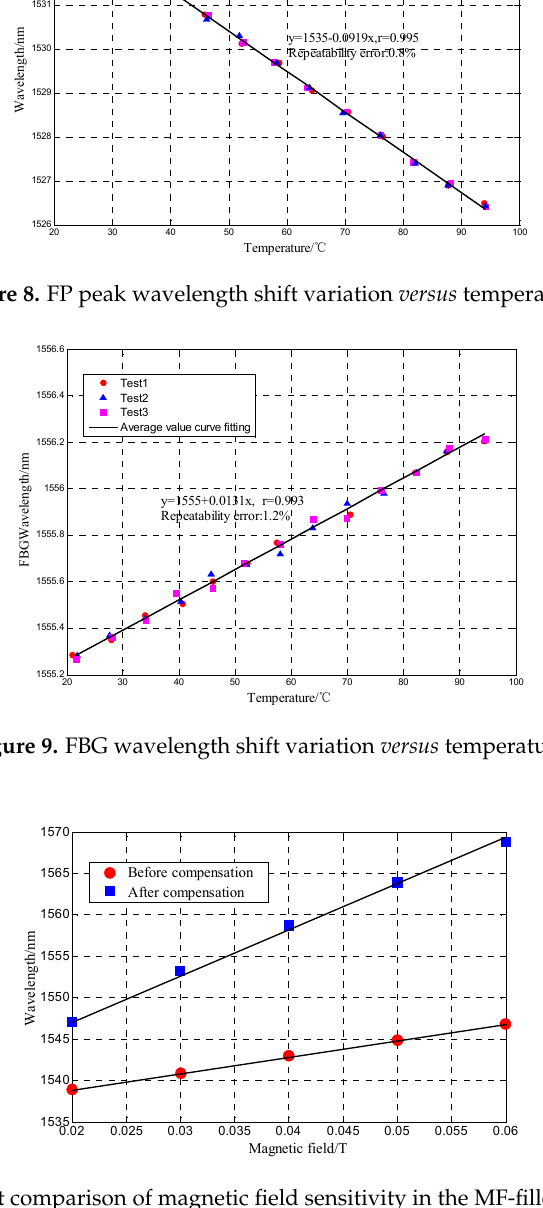
Figure 10. The test comparison of magnetic field sensitivity in the MF-filled FP-FBG sensor.